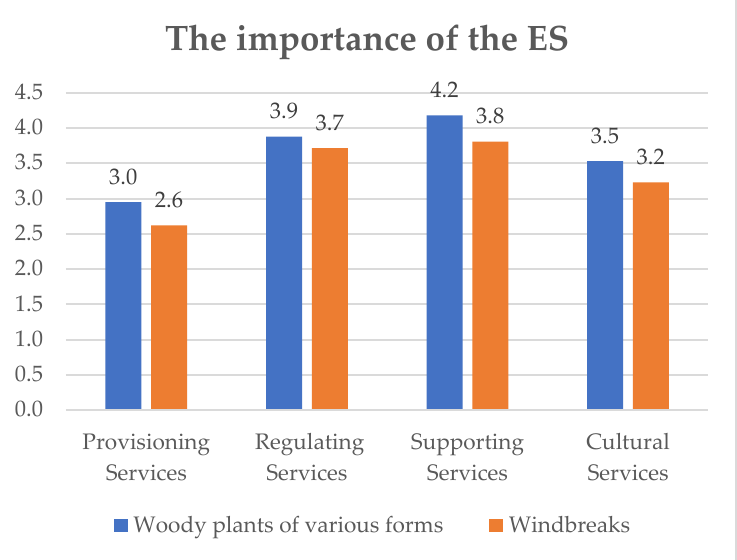
Figure 6. Comparison of the importance of different ES categories for windbreaks and other forms of tree planting on agricultural land.